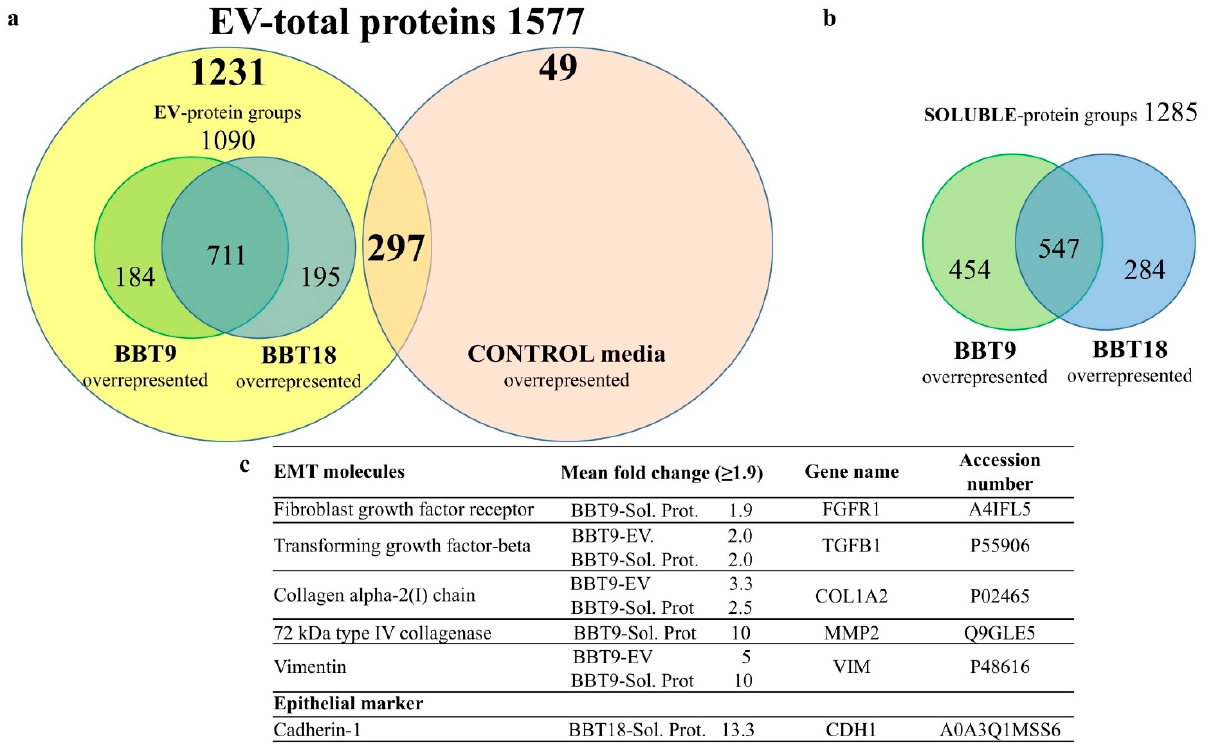
Figure 2. BBT-9- and BBT-18-derived secretomes contain EV-cargo proteins and soluble proteins. Venn diagrams of overrepresented EV-cargo proteins ( a ), or soluble proteins ( b ) identified by iTRAQ-LC-MS/MS analysis, overexpression ≥ 1.9-fold has been considered in all comparative analyses. Characteristic EMT expression markers identified and overrepresented in BBT-9-secretome and epithelial marker CDH1 overrepresented in BBT-18-soluble fraction ( c ).